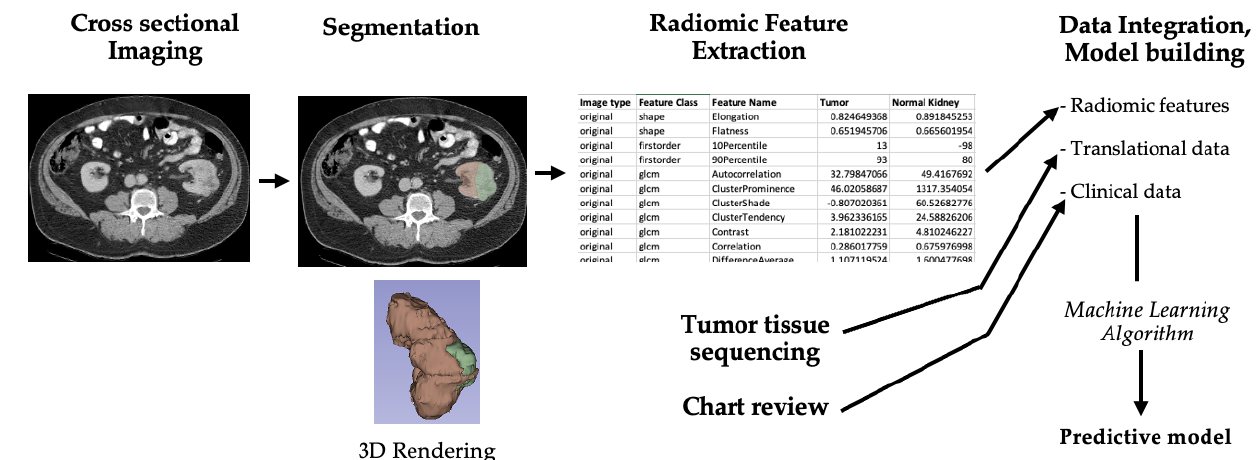
Figure 2. Flowchart showing typical radiogenomic workflow. Using cross-sectional images, a region of interest (ROI) that contains either the whole tumor or subregions within the tumor can be identified and outlined using manual in process called segmentation, using semi-automated, or automated segmentation software. Some segmentation software, such as 3D Slicer (shown above) allow for further ROI rendering in 3D dimensions. Quantitative radiomic features are extracted from ROI using separate or built-in radiomic feature extraction modules. Finally, this data is integrated with corresponding tumor molecular profile, as well as patient clinical data. These data are then processed using machine learning algorithms to develop diagnostic, predictive, or prognostic models for outcomes of interest.